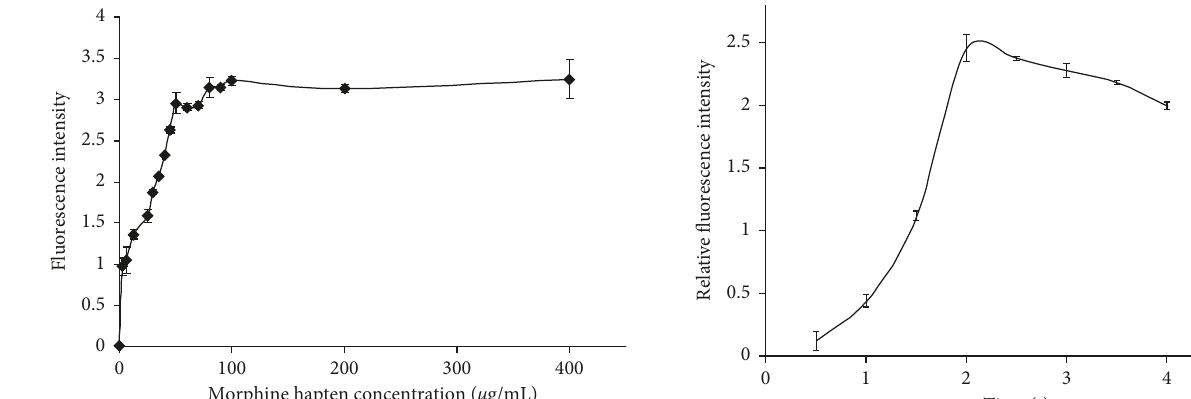
Figure 6: Incubation time curve for antigen-antibody reaction.